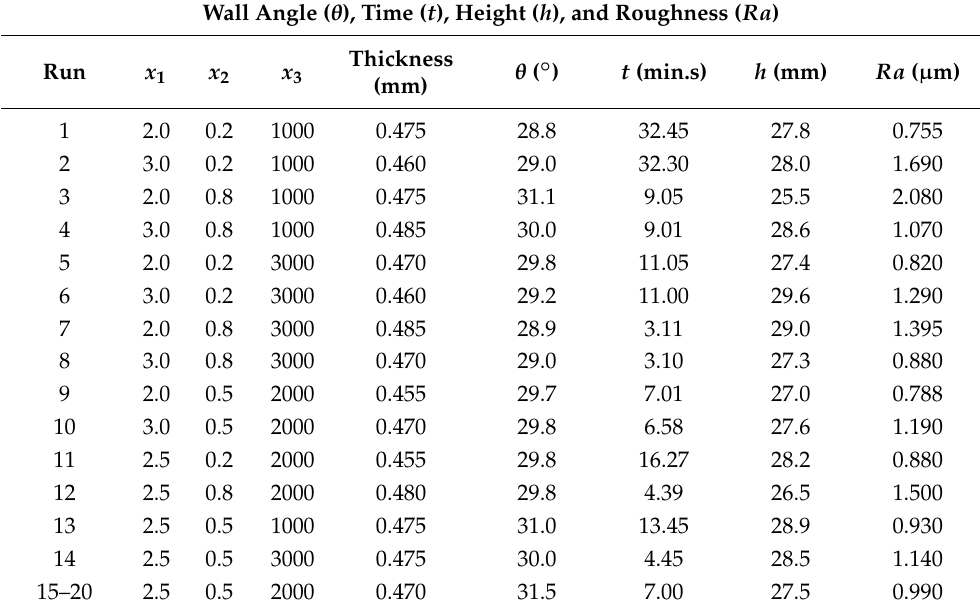
Table 3. CCF experimental design and experimental results using a 30° cone angle.